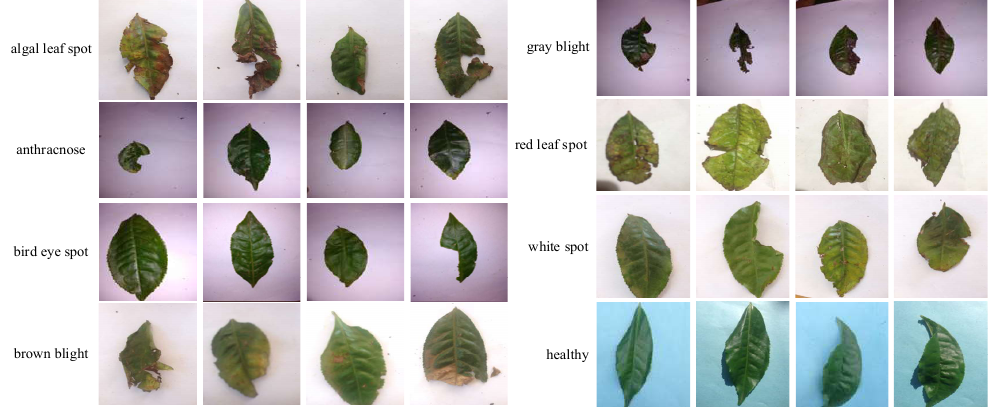
Figure 4. Types of tea disease images.